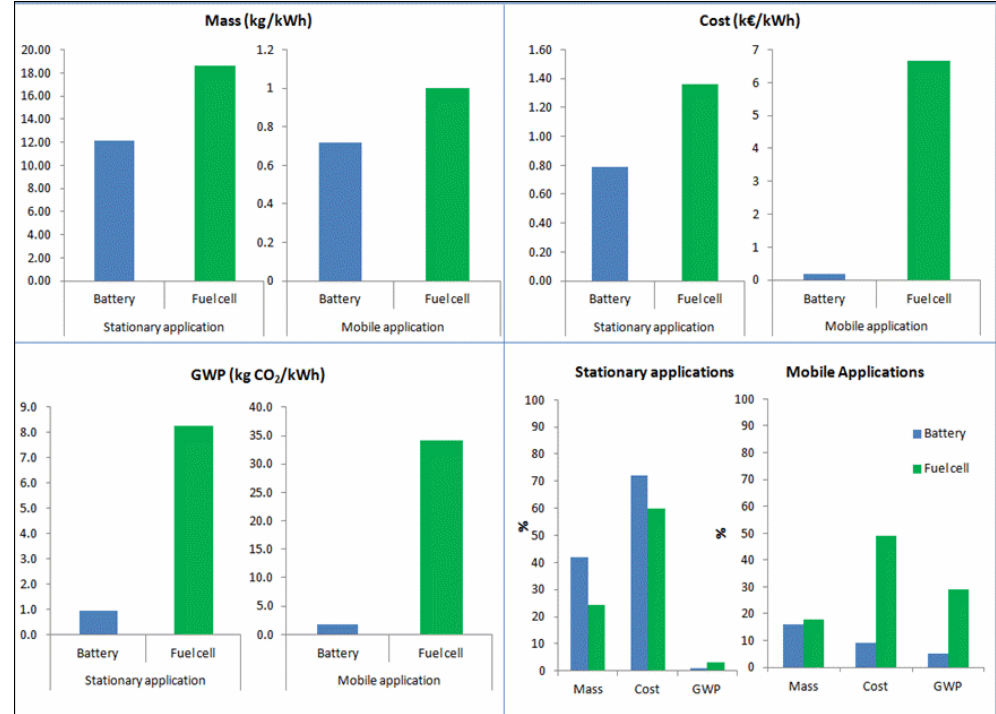
Figure 12. Results normalized per kWh energy supplied for the different examined systems.